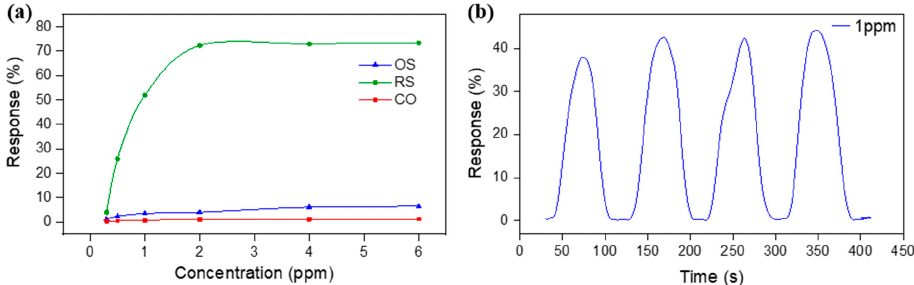
Figure 9. ( a ) Relationship between the sensing response of the Sn 3 O 4 -RGO-based sensor and CH 3 COOH concentration. ( b ) Dynamic transient response curves of the Sn 3 O 4 -RGO-RS sensor to 1 ppm CH 3 COOH during the four cycles of the test.